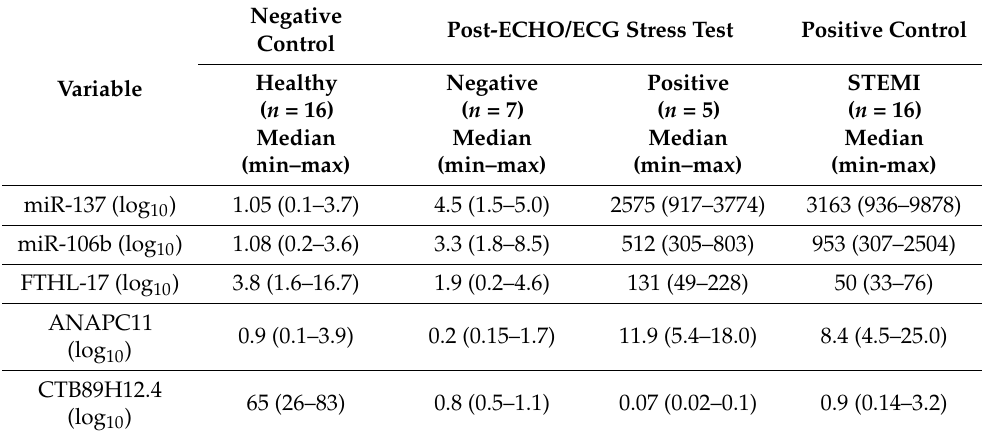
Table 2. Post-ECHO/ECG stress test gene expression profiles of chest pain patients with positive and negative stress test versus healthy (negative controls) and STEMI (positive